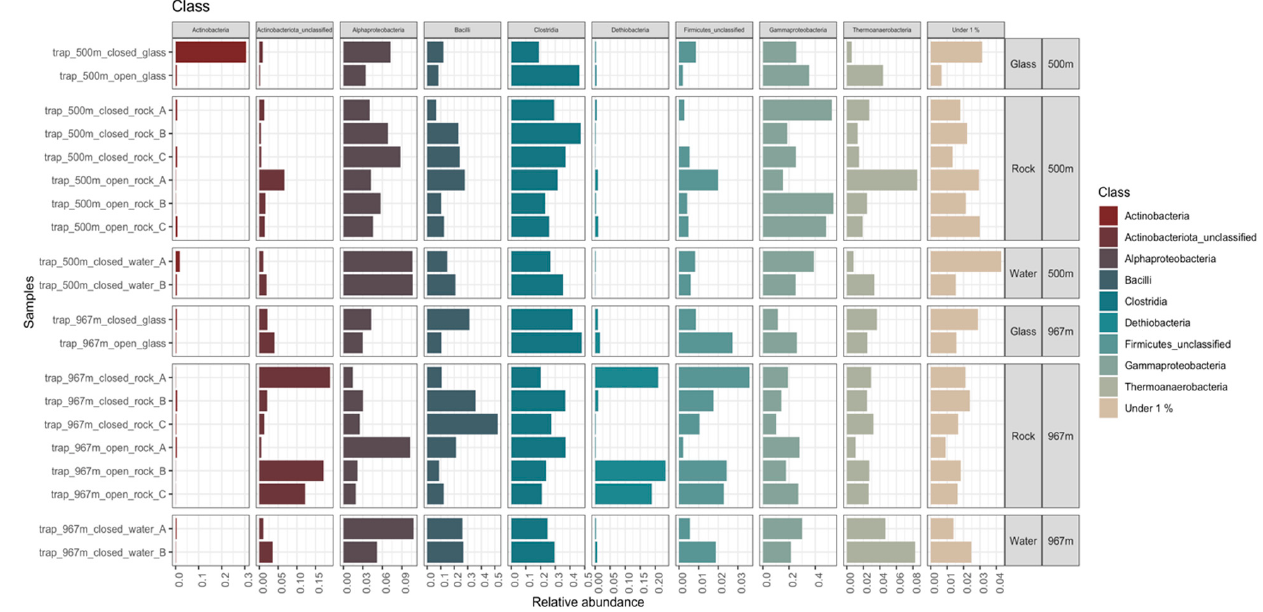
Figure 9. Bacterial communities from depths 500 and 967 m, and on different surfaces (glass, rock, water) presented at class level. All classes present at less than 1% relative abundance are merged as group “Under 1%”. Notice class-wise relative abundance and compare samples within class, not across